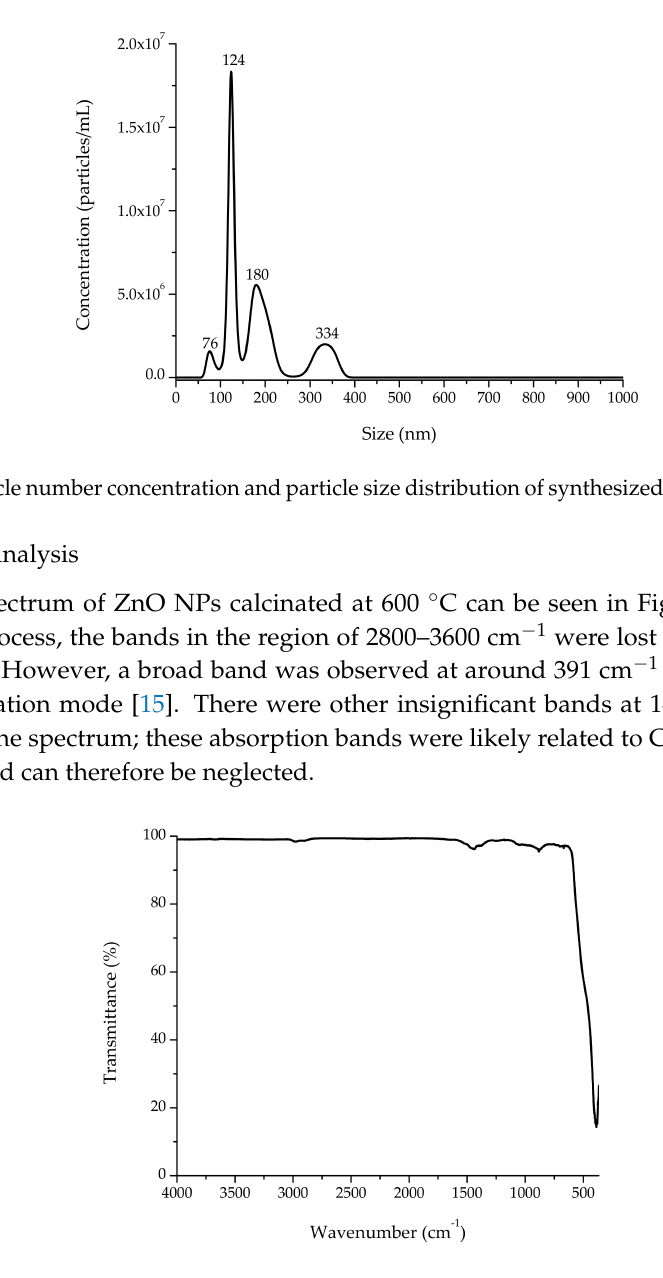
Figure 6. Typical Fourier transform infrared spectroscopy with attenuated total reflection (FTIR-ATR) spectrum of synthesized ZnO